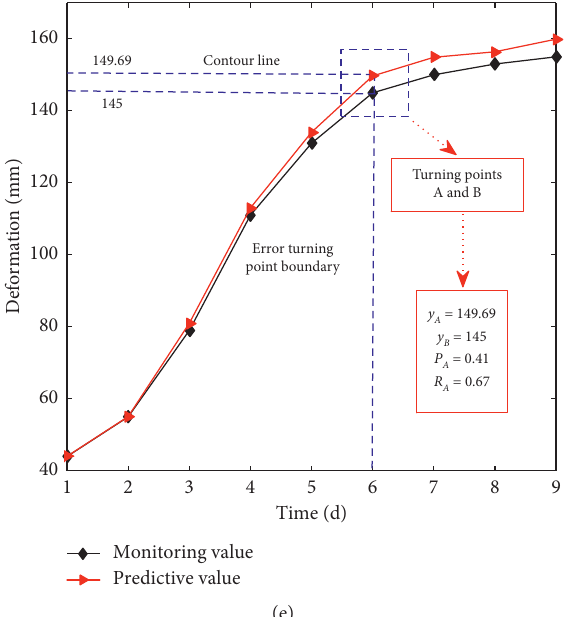
Figure 3: Schematic diagram of comparative analysis of tunnel deformation prediction value and monitoring value: (a) S (right); (c) S 2 (left); (d) S 2 (right); (e) dome.